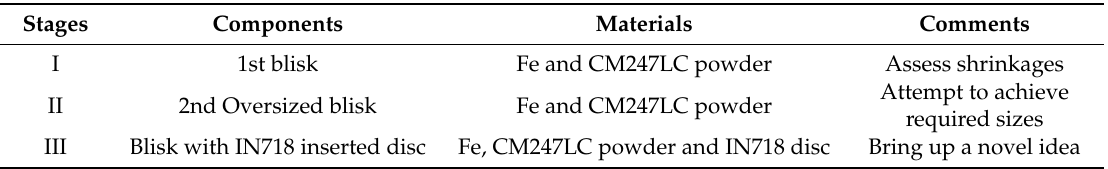
Table 2. Summary of key stages alongside components being designed in Selective Laser Melting / Hot Isostatic Pressing (SLM / HIPping)